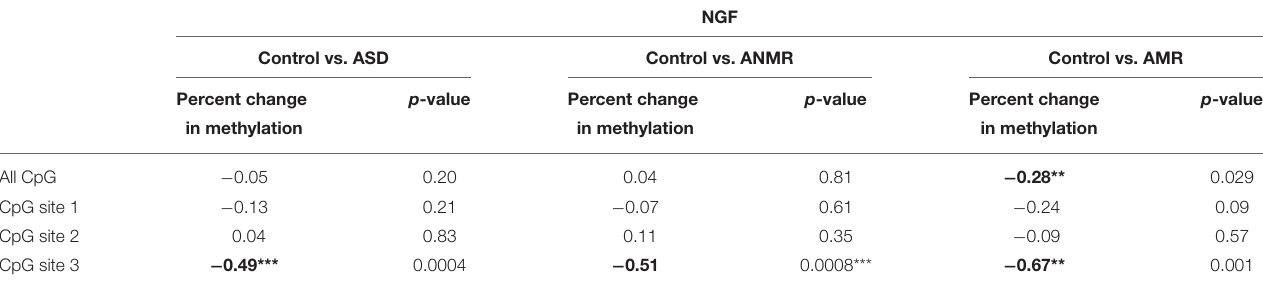
TABLE 5 | Pyrosequencing results of NGF showing percent change in methylation in ASD group, ANMR and AMR subgroups compared to healthy control group.